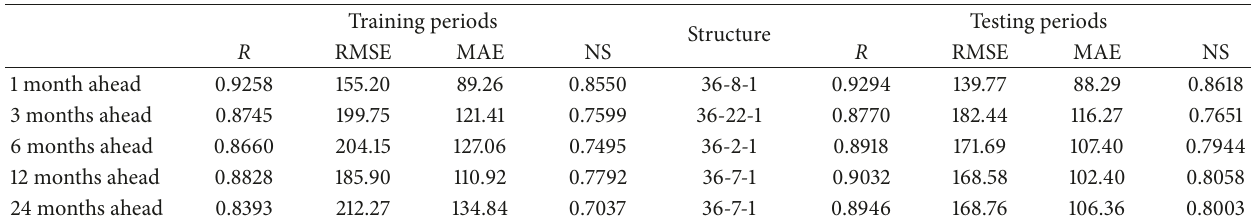
Table 5: Performance statistics of the ANN model with three input variables (runoff, precipitation, and air temperature) during the training and testing periods for 1-, 6-, 12-, and 24-month-ahead runoff forecasting in the LARHR.